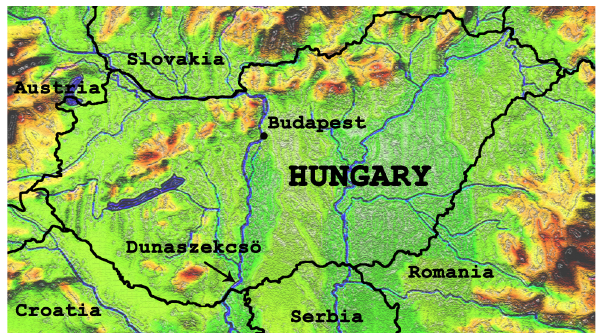
Fig. 1. Location of the landslide at the Danube river, near Dunaszekcs¨o,